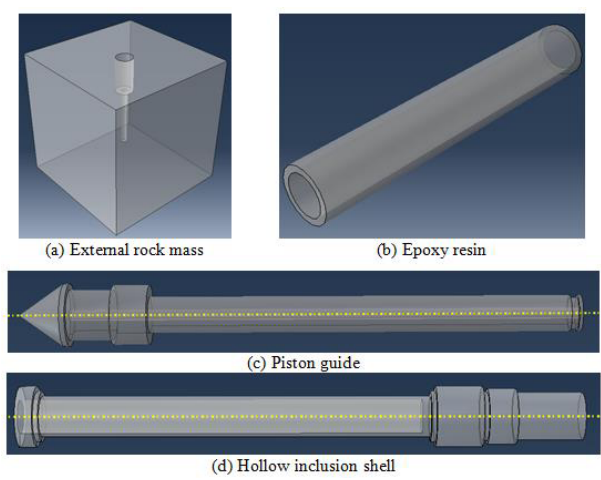
Figure 14. The 3D model of each part of the CAE